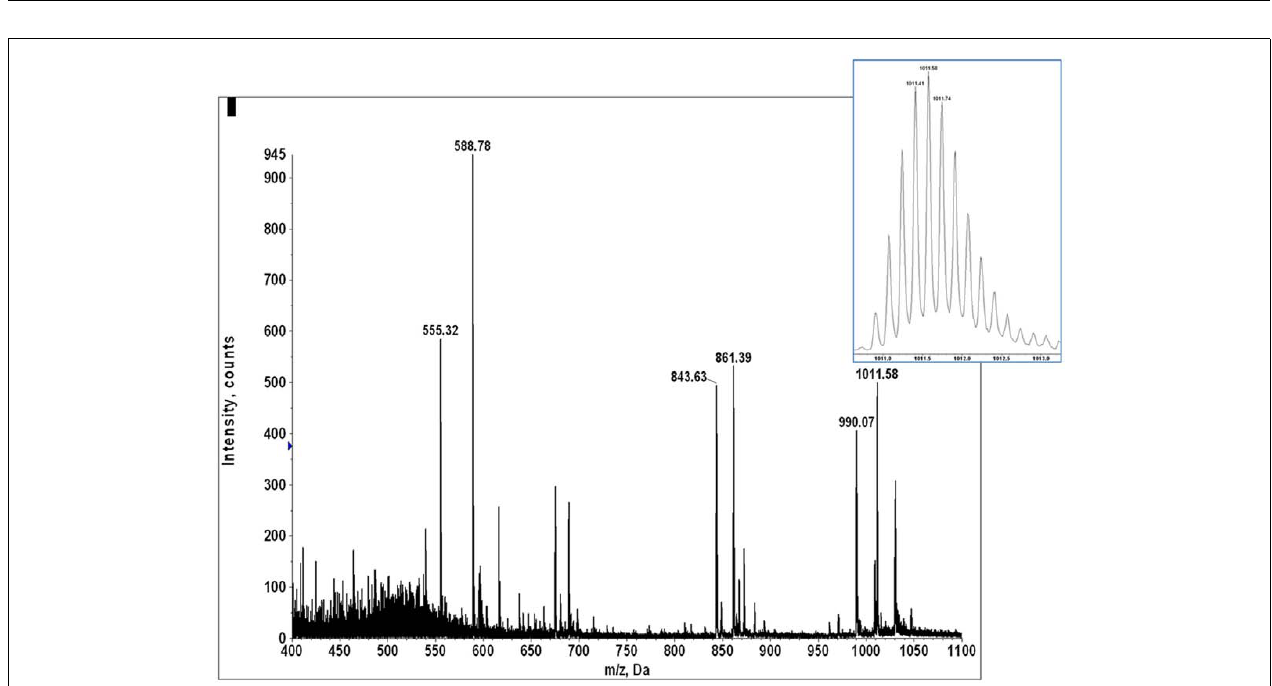
FIGUREA5 |The nanospray MS spectrum of peptides recovered from KTS6 taken with a quadrupole–oTOF instrument shows a substantial background of ion masses around 6kDa (inset showing isotope peaks in the sixth charge state).